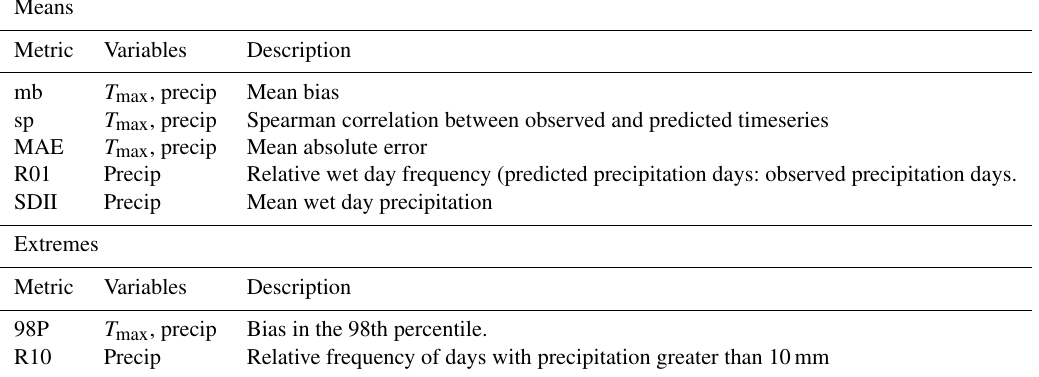
Table 2. Evaluation